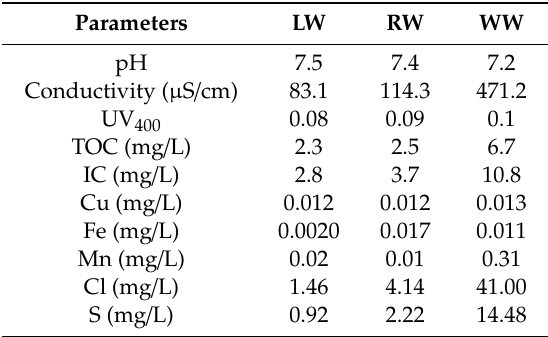
Table 1. Properties of real water